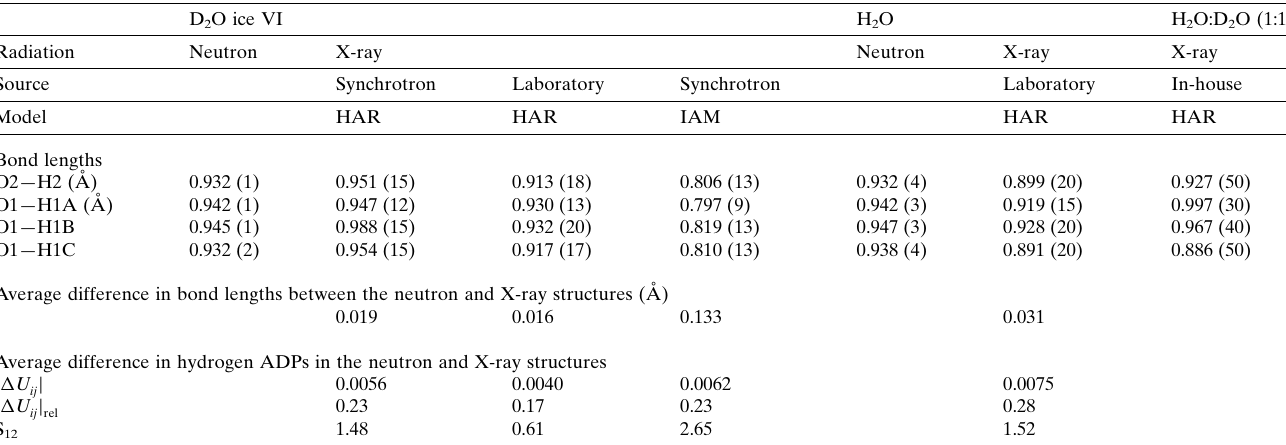
Table 1 Comparison of bond lengths and hydrogen ADPs in ice VI. For ADP values see the supporting information. j (cid:3) U ij j is the average absolute difference between ADP components, j (cid:3) U ij j account the relative difference of each ADP but is divided by the average value and S 12 is the average similarity index for the hyrogen ADPs.